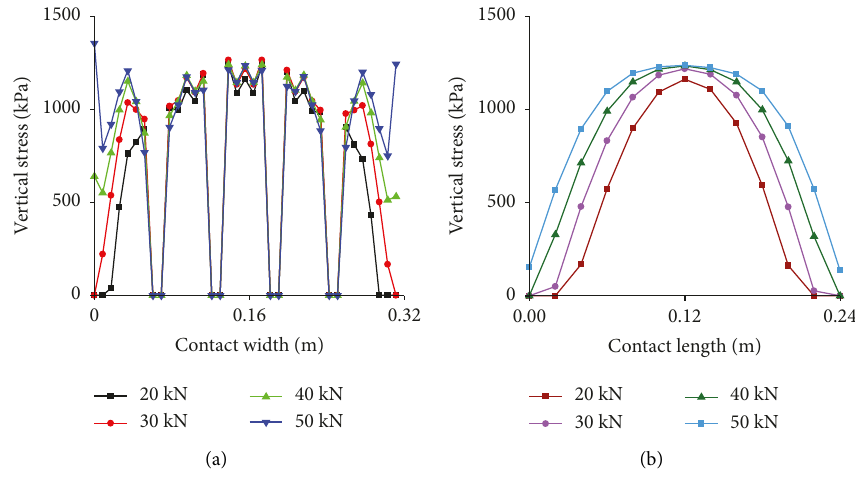
Figure 8: Vertical stress under different loads: (a) width and (b) length.